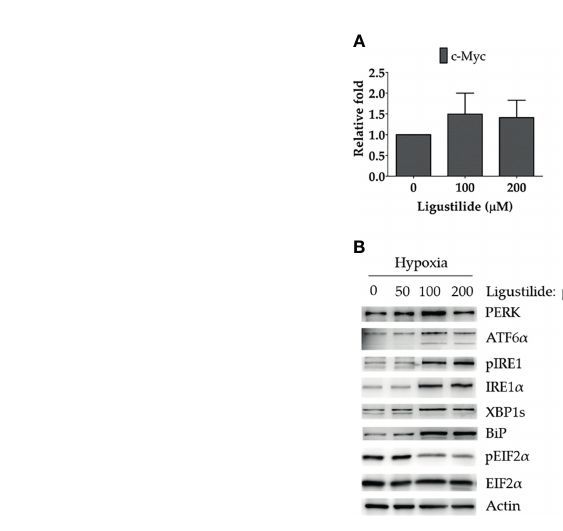
FIGURE 3 | Effects of ligustilide on c-Myc mRNA and ubiquitinated c-Myc levels in hypoxic TW2.6 cells. (A) TW2.6 cells were treated with ligustilide and incubated for 24 h of hypoxia at 37°C. Messenger RNA and protein were harvested and c-Myc mRNA was measured (left). Ubiquitinated c-Myc levels were measured by immunoprecipitating c-Myc with anti-c-Myc antibody followed by detection with speci fi c anti-ubiquitin or anti-c-Myc antibodies (right). Data in the plot are expressed as mean ± SEM ( n ≥ 3). (B) Effects of ligustilide on ER stress-related signaling in hypoxic TW2.6 cells. Cells were treated with ligustilide in different doses and incubated at 37°C under hypoxia for 24 h. Protein was harvested and analyzed by Western